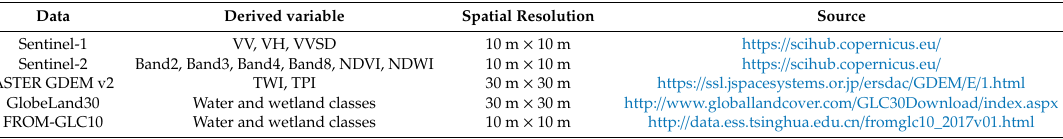
Table 1. Information in respect of the data sets used in the study.